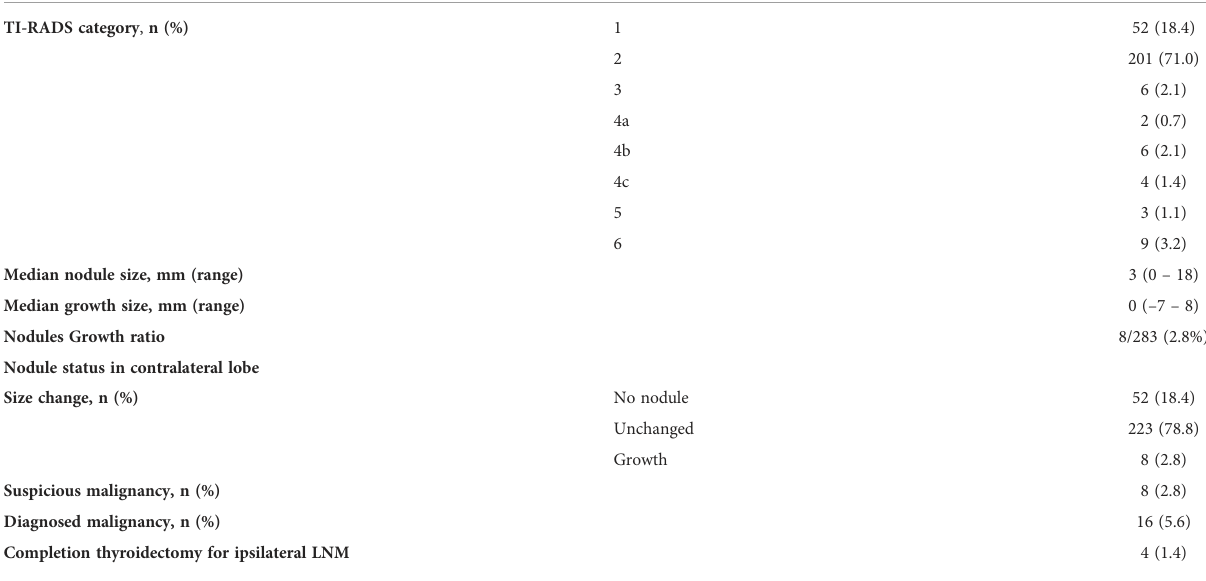
TABLE 2 Characteristics of nodules in contralateral lobe after a period of follow-up.